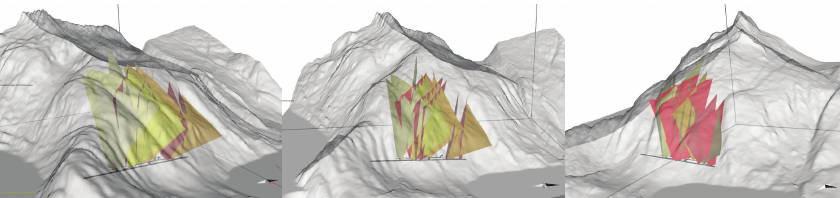
Figure 15. Representation in 3-D of the maximum a posteriori model of fault geometry with three different angles of view. N is indicated by the black triangle. The black tunnel is 717m